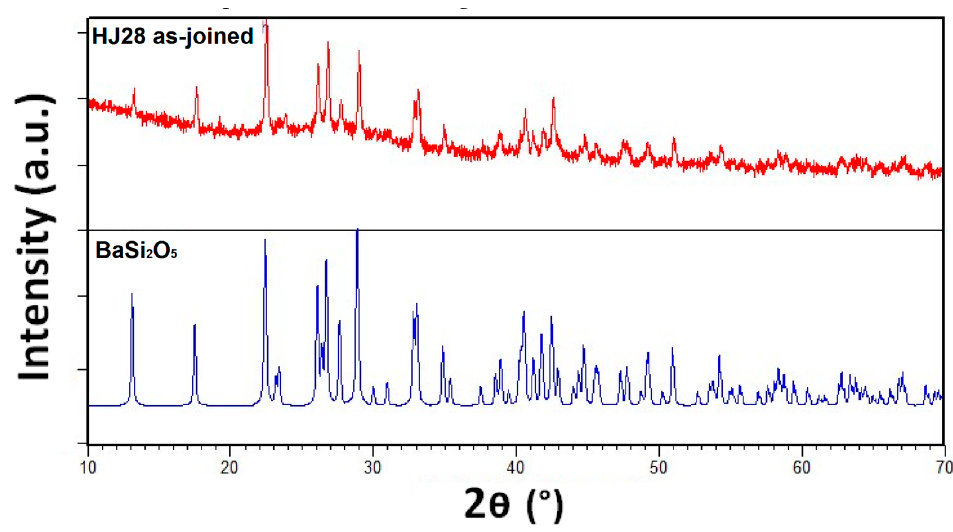
Figure 3. XRD pattern of HJ28 glass ‐ ceramic synthesized at 950 °C for 2 h at heating rate of 2 °C/min.